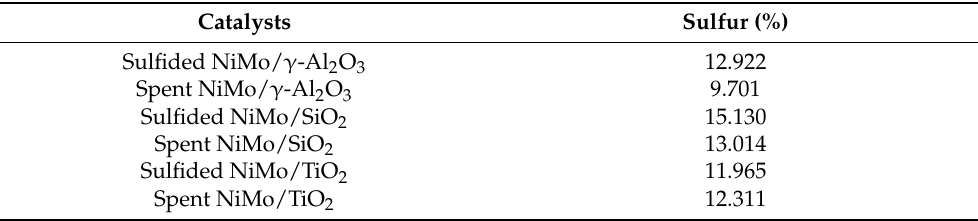
Table 5. Sulfur content of sulfide catalysts initially and after 15 h of the reaction analyzed by energy dispersive X-ray